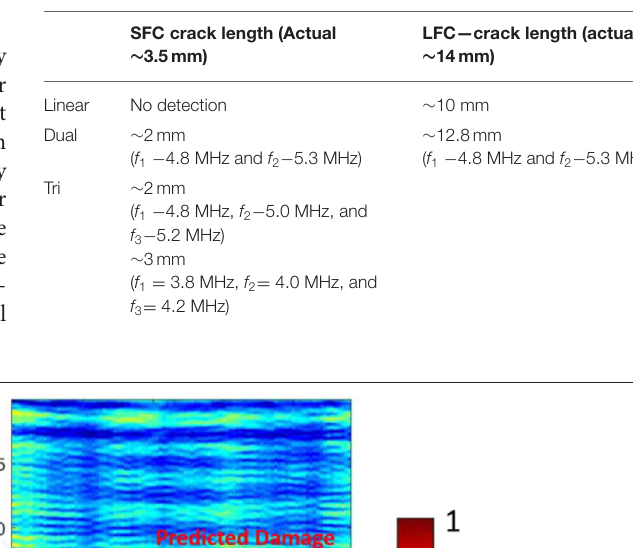
Frontiers in Built Environment |